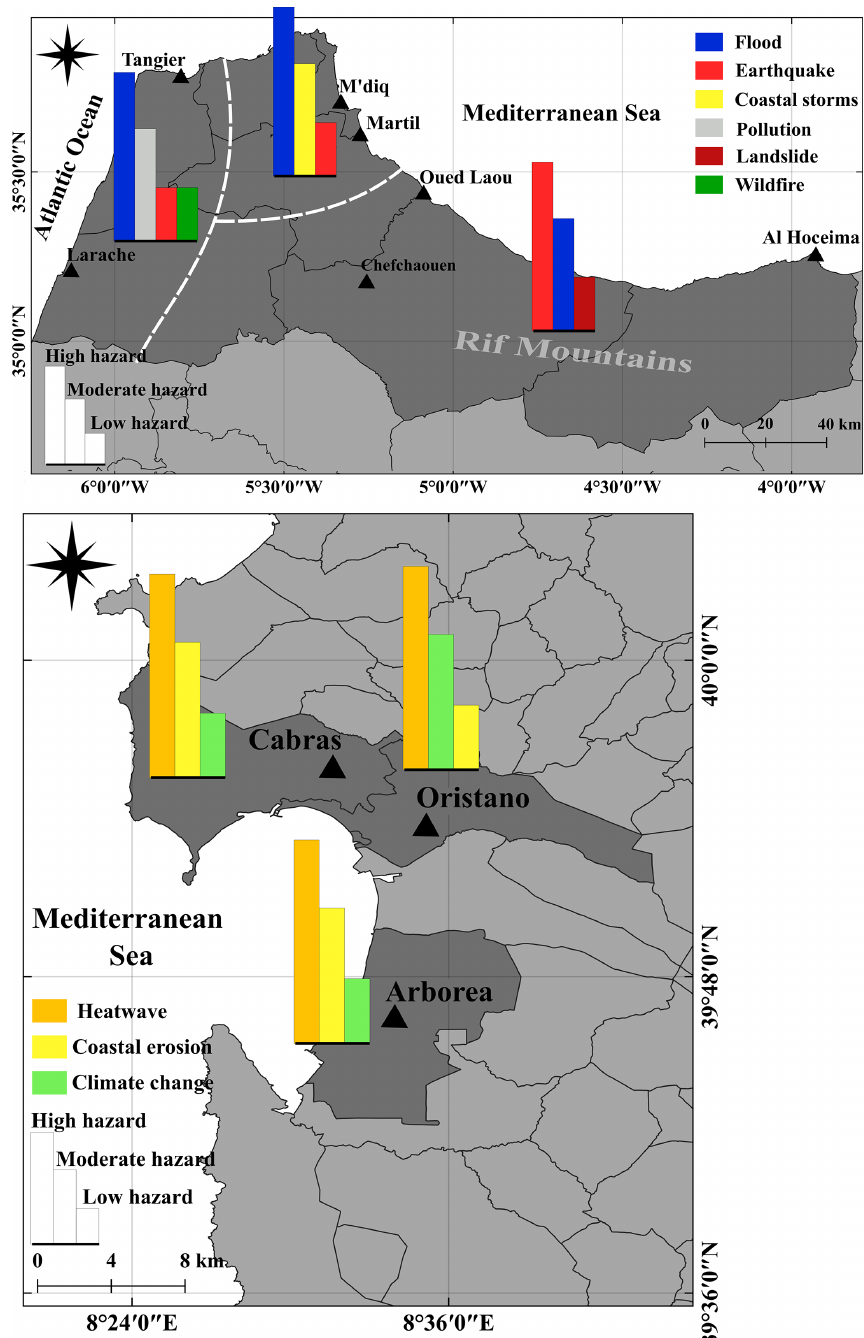
Figure 6. Differences in main hazards perceived in north Morocco and west Sardinia by the general